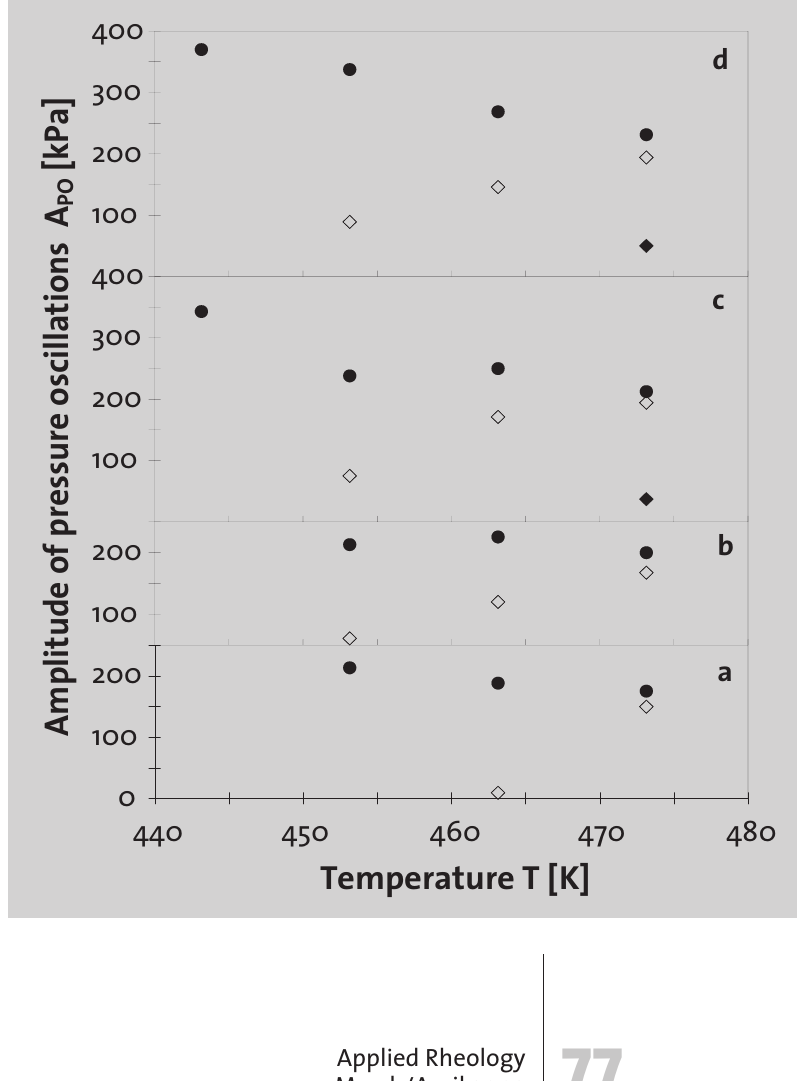
Figure 5 (right): Amplitude of pressure oscillations of compound containing 45 ( Ï ), 50 ( Ì ) and 55 ( Ê ) vol. % carbide powder at apparent shear rates 300 (a), 500 (b), 1000 (c) and 1500 (d) s-1 as a function of absolute temperature (Goettfert, L CAP /D CAP ratio